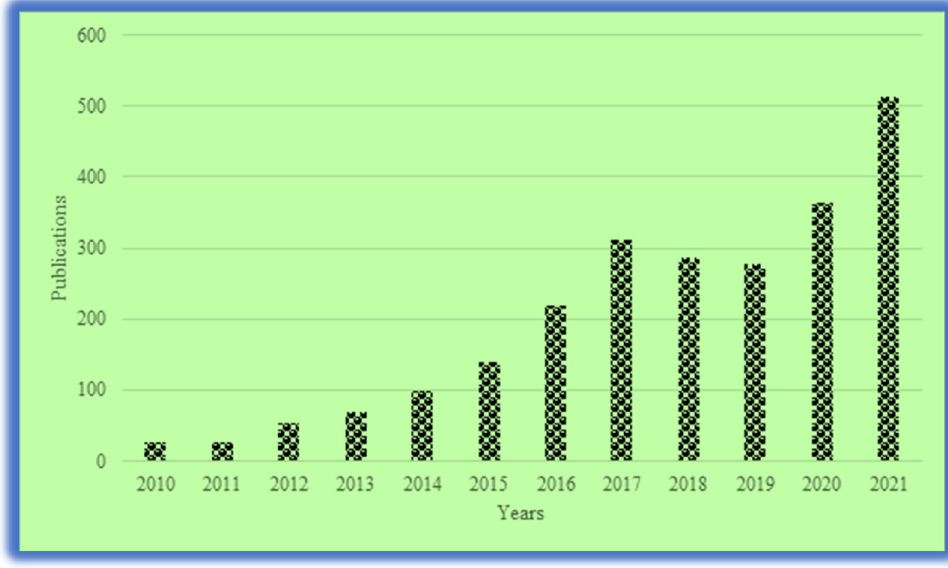
Figure 3. Area-wise contribution of publications on nanofluids published in different domains (source: Scopus.com).